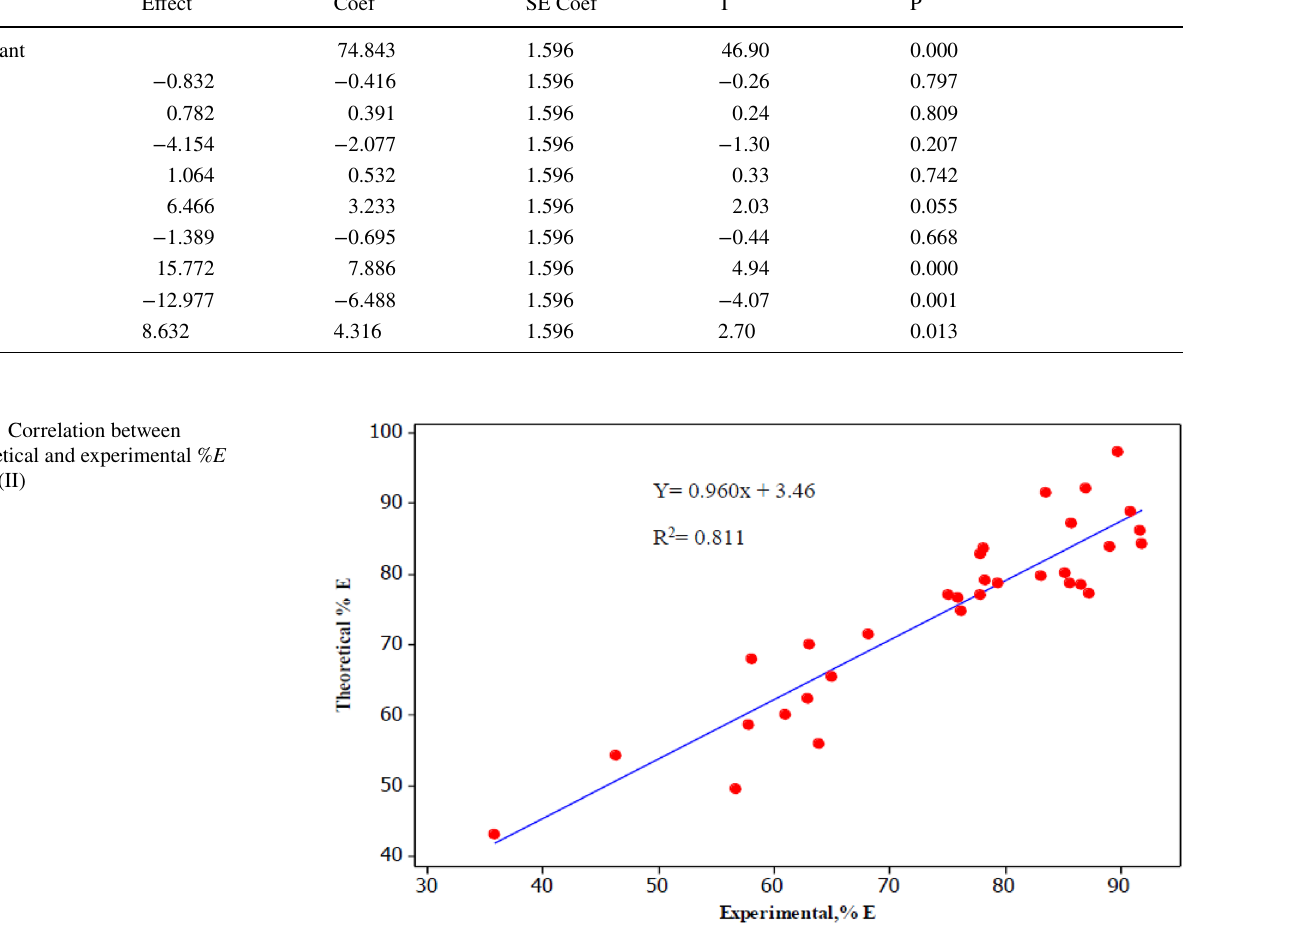
Table 7 Estimated effects and coefficients for % E of Cu(II) after adjustment Term